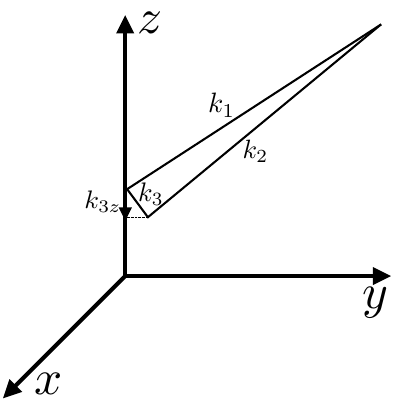
Figure 8 . This (cid:12)gure shows how we measure the non-Gaussianity. The z direction denotes the direction of the electric (cid:12)eld. When we measure the non-Gaussianity, we should (cid:12)x the ratio of the long wavelength momentum and the short wavelength momentum k measure the angular dependence of the non-Gaussianity for di(cid:11)erent k of the long wavelength momentum projected onto the z direction.